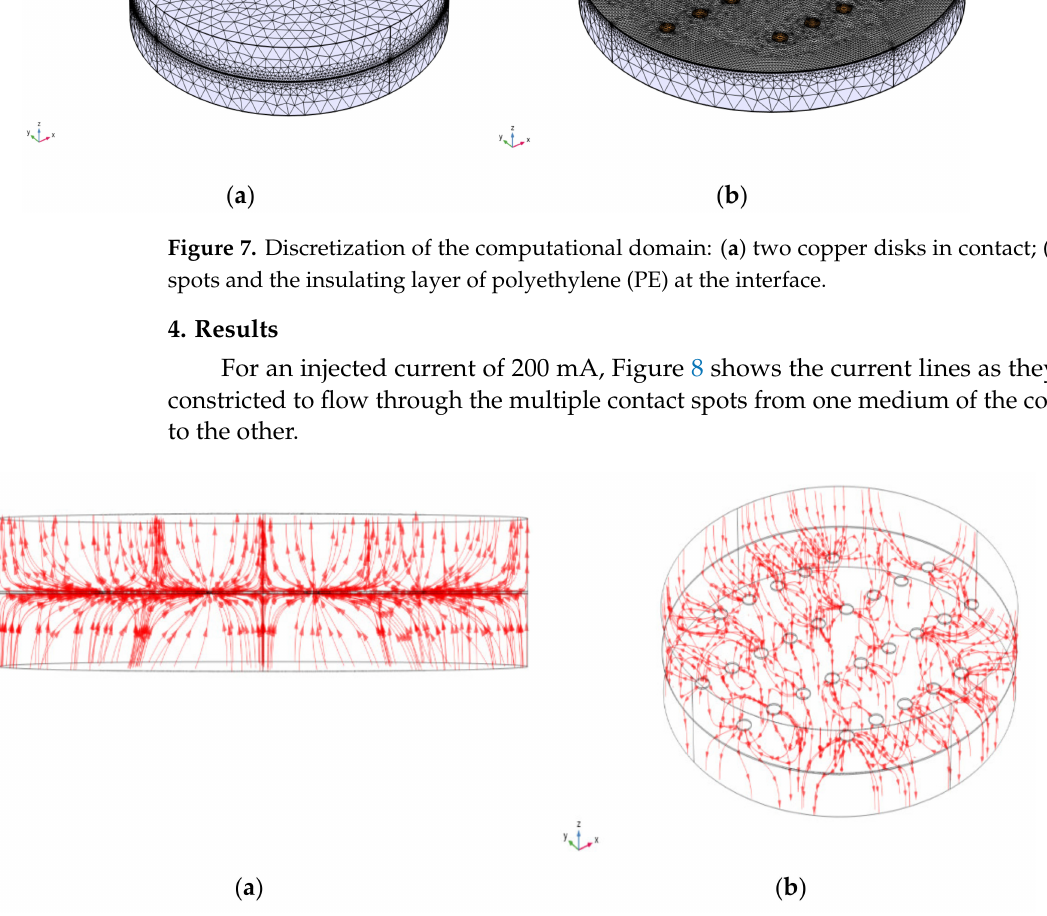
Figure 8. The current line constricted at the contact spots: ( a ) two-dimensional view and ( b ) three- dimensional